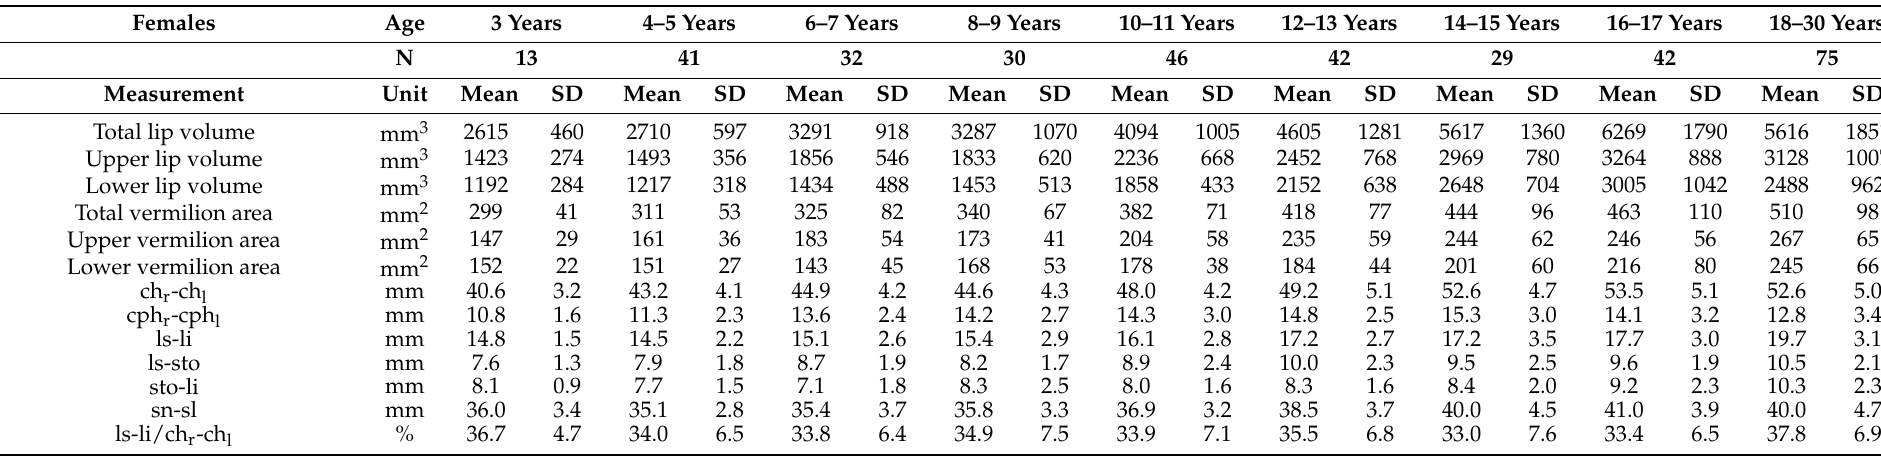
Table 1. 3D soft tissue labial volumes, areas, distances and ratios in healthy Sudanese females of Arab descent.